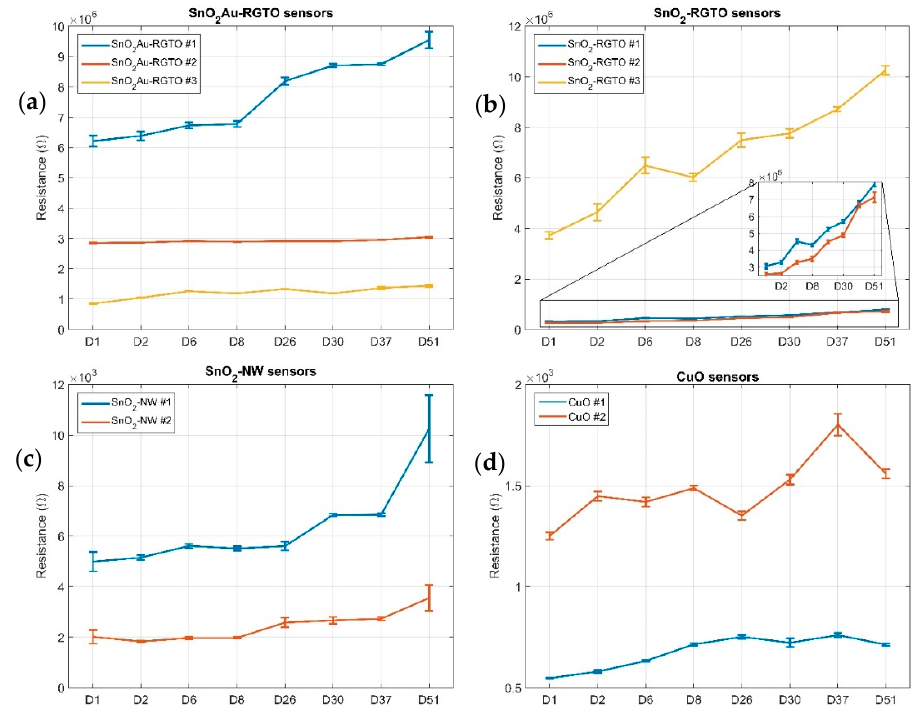
Figure 2. Baseline drift of all the sensors from day 1 to day 51, divided for typology. ( a ) Drift of the 3 SnO 2 Au RGTO sensors; ( b ) drift of the 3 SnO 2 RGTO sensors; the trend of sensor #1 and #2 is zoomed in the box on the right part of the image; ( c ) drift of the 2 SnO 2 NW sensors; ( d ) drift of the 2 CuO sensors.